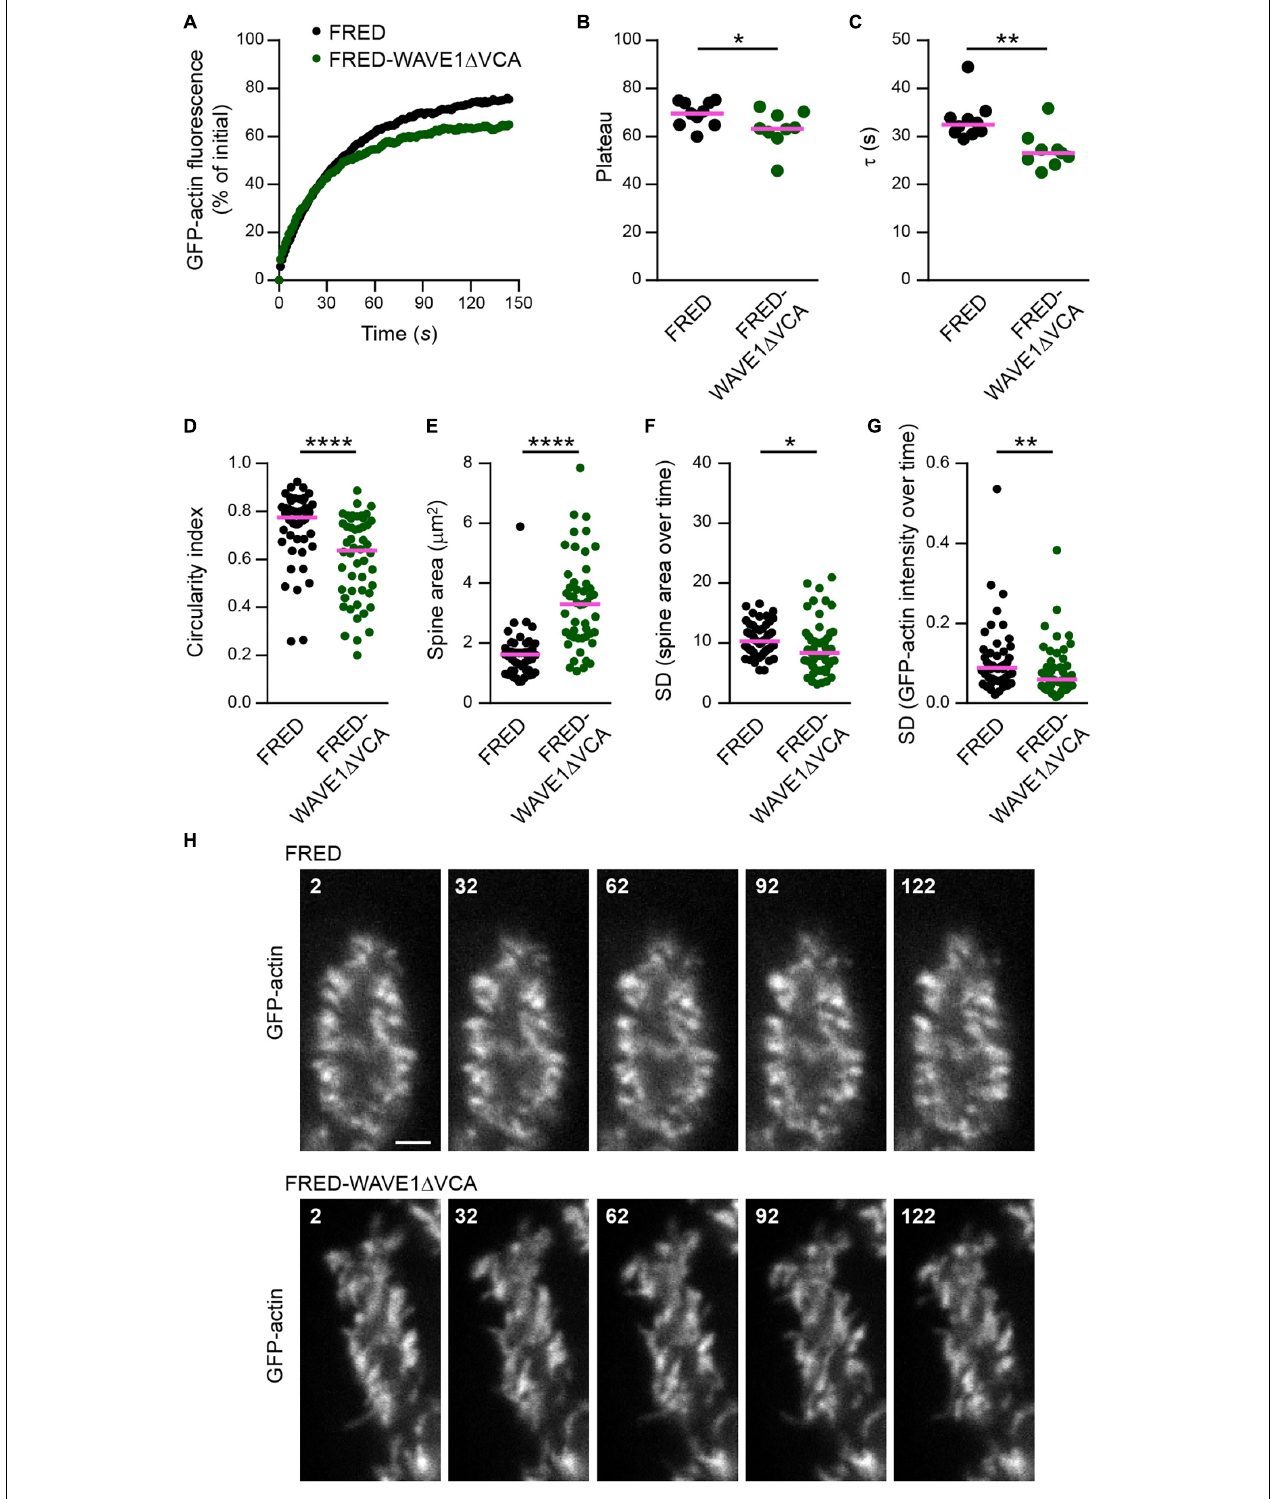
FIGURE 6 | WAVE1 (cid:49) VCA leads to accelerated F-actin turnover and a decreased dynamic F-actin pool in Purkinje cell dendritic spines. (A) FRAP analysis of GFP-actin in spines of wild-type PCs transfected with L7/Pcp-2 promoter plasmids encoding either FusionRed-tagged WAVE1 lacking the VCA domain (FRED-WAVE1 (cid:49) VCA) or FusionRed alone (FRED). Cells were co-transfected with a plasmid encoding GFP-actin. Graph depicts recovery of GFP-actin fluorescence intensity in spines, data points represent the mean of a representative experiment. (B) GFP-actin FRAP recovery plateau in spines of PCs